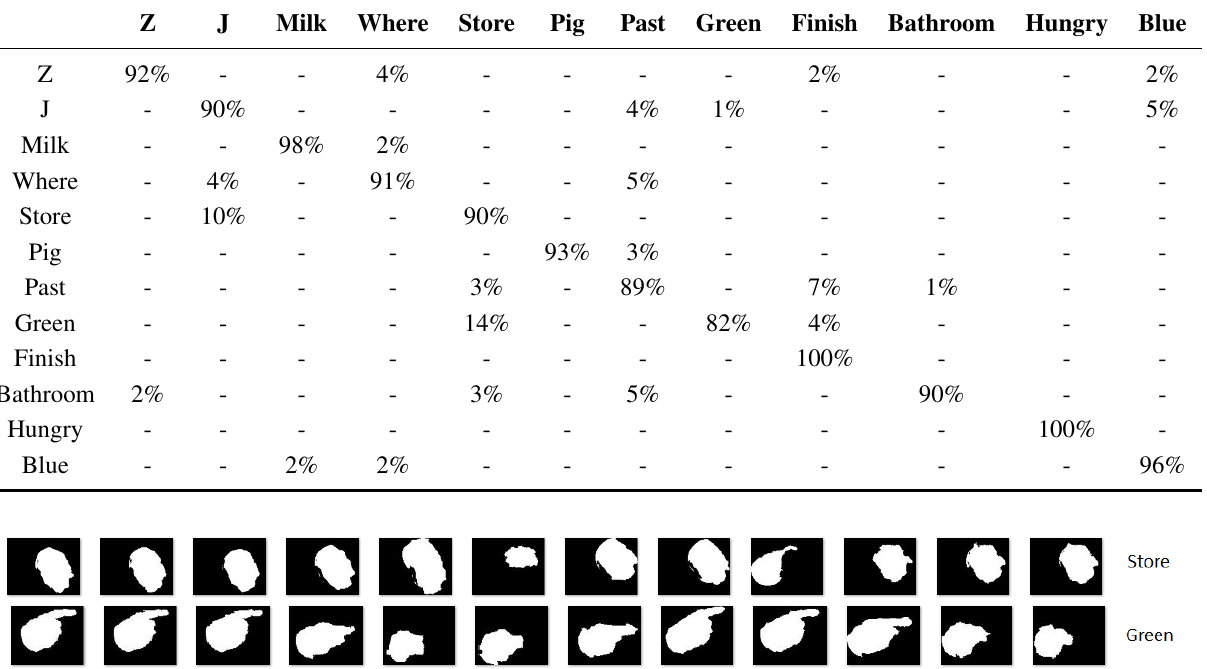
Table 3. Confusion matrix of the MSRGesture3D database results classified by the CIPBR + DTW combination.